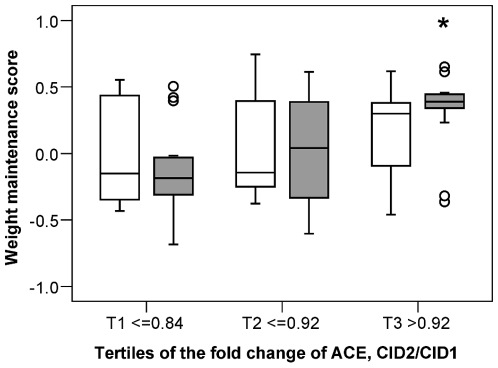
The relation between weight maintenance score and the fold change of ACE during weight loss.Boxplot shows the quartile range of weight maintenance score with outliers (in circle) across tertile of the fold change of ACE during weight loss, for subjects with low (≤9.6µmol/L, n = 48, blank bar) and with high (>9.6 µmol/L n = 47, grey bar) baseline fibrinogen level. The variation of weight maintenance score attributed to the fold change of ACE, p = 0.478 in low group and p = 0.014 in high group, was tested by one-way ANOVA controlled for age and the fold change of weight, and Bonferroni test for multiple comparisons. *T3 significantly different from T1 in high fibrinogen group, p = 0.013.